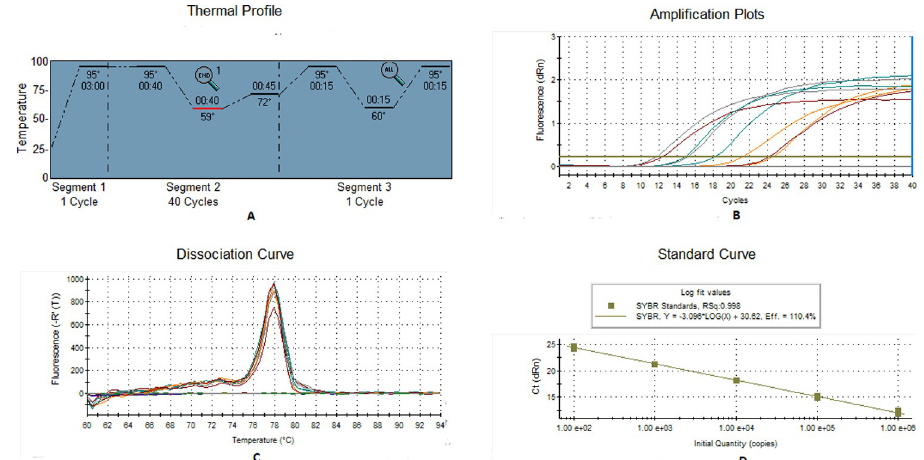
Fig 2. Real-time PCR analysis of YVMV indicate the specificity of the reactions (A) Thermal profile (B) PCR amplification plots (C) dissociation curve and (D) standard curves of serially diluted linearized plasmids obtained using SYBR 1 Green chemistry. The specific melting temperature for YVMV products was around 78˚C. Standard curves show a linear relationship between initial viral copy number per microliter on X-axis and Ct values on Y-axis. Each concentration was replicated twice. The equation of the straight line and the coefficient of correlation (R 2 ) are mentioned on the graph.